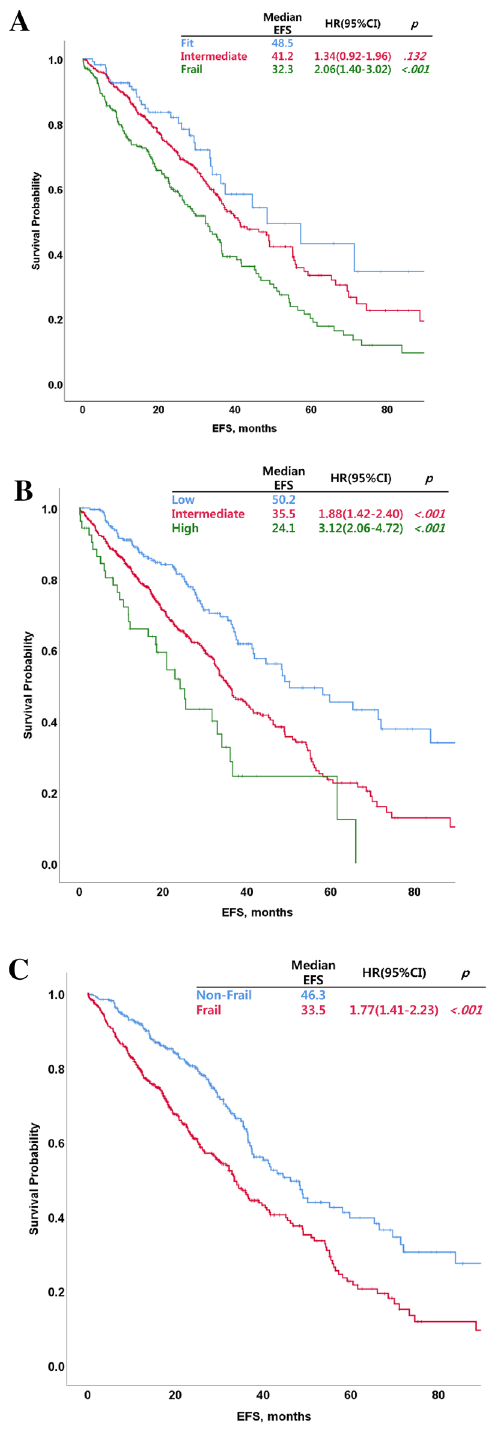
Figure 3. Event-free survival (EFS) by group as identified using different frailty assessment tools. EFS of groups classified using the new clinical frailty index ( A ), revised myeloma comorbidity index ( B ), and simplified frailty scale ( C